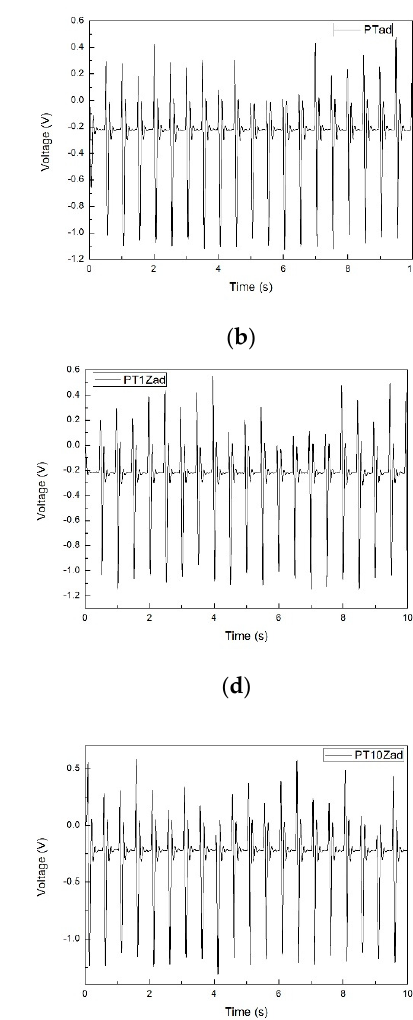
Figure 6. Histogram for β phase crystal size.